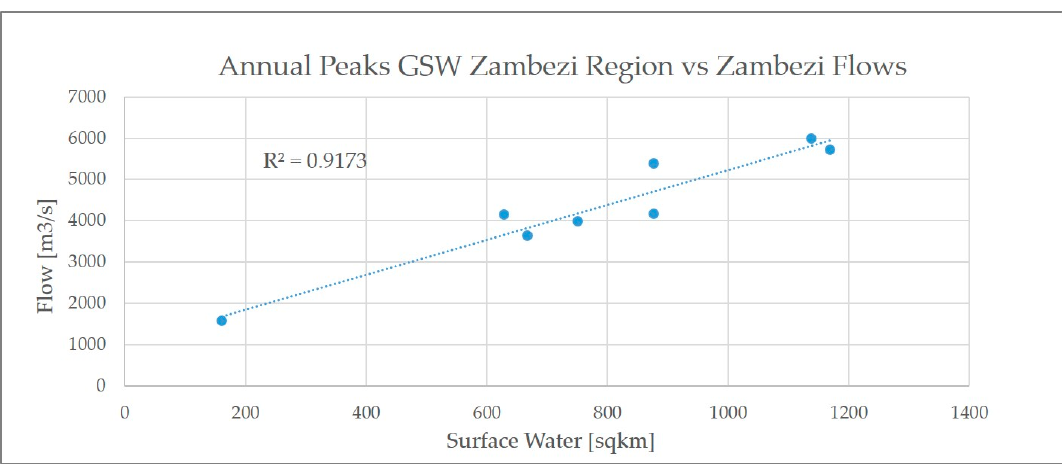
Figure 11. Comparison of surface water in April 2009 (blue) and April 2015 (purple) in the Zambezi Region. 3.2. Access to Roads (Indicator 9.9.1) Figure 12 shows a visual comparison between OpenStreetMap (OSM) [39] and the NSA’s official roadmap [40]. It can be seen that OSM detects more roads than the official roads dataset (Figure 12a) and that it shows unconfirmed roads and objects such as fences classified as roads (Figure 12b). Due to this lack of road quality information and in line with the World Bank approach [67], the OSM was not considered for the further assessment of access to roads for Namibia.